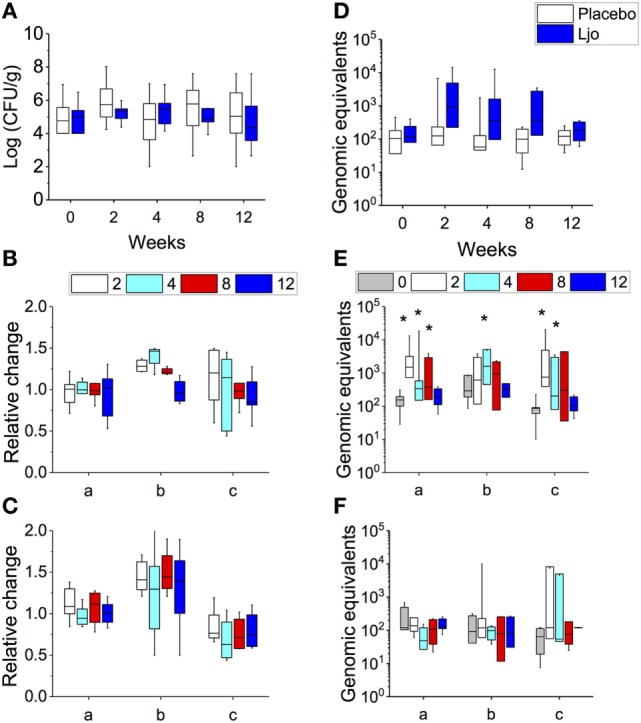
Determination of total lactic acid bacteria (LAB) and L. johnsonii N6.2 (Ljo) in stool samples. In placebo and Ljo groups, it was determined: (A) total number of LAB (Log CFU/g). Based on the numbers of LAB obtained, three subgroups were defined: (a) high LAB, (b) low to high LAB, and (c) low LAB. (B) Relative change in LAB for Ljo. (C) Relative change in LAB for placebo. (D) The presence of Ljo was confirmed by performing qRT-PCR of the T285_00345 gene and expressed as genomic equivalents. These data were further stratified based on the determination of total LAB numbers for the Ljo (E) and placebo (F) treatment groups. * indicates statistical differences (p < 0.05) between the groups and time points shown in panels (E,F) using analysis of variance. Comparison of the treatment combinations was performed by least significance difference with a significance level of 5%.